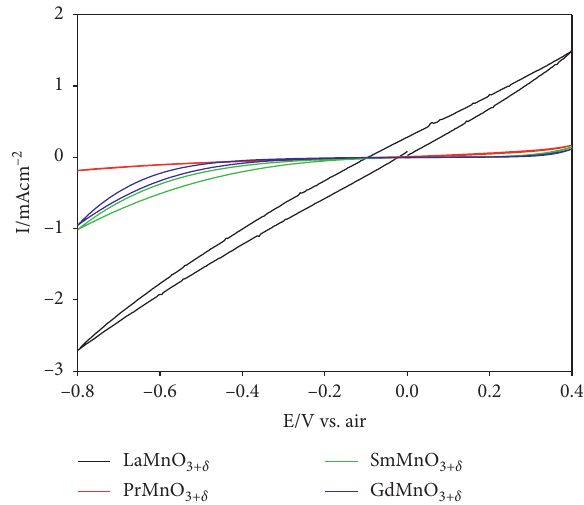
Figure 5: The response in the form of voltammograms from the 2 in Ar four manganite-based perovskite-based cone-shaped electrodes in 1% NO in Ar at 200 C with a sweep rate of 1mV/s. A large dif- ference is observed between the four manganite-based perovskites. The LaMnO 3+ δ perovskite is by the far the most active. The ac- tivities of the SmMnO 3+ δ and GdMnO 3+ δ perovskites are almost